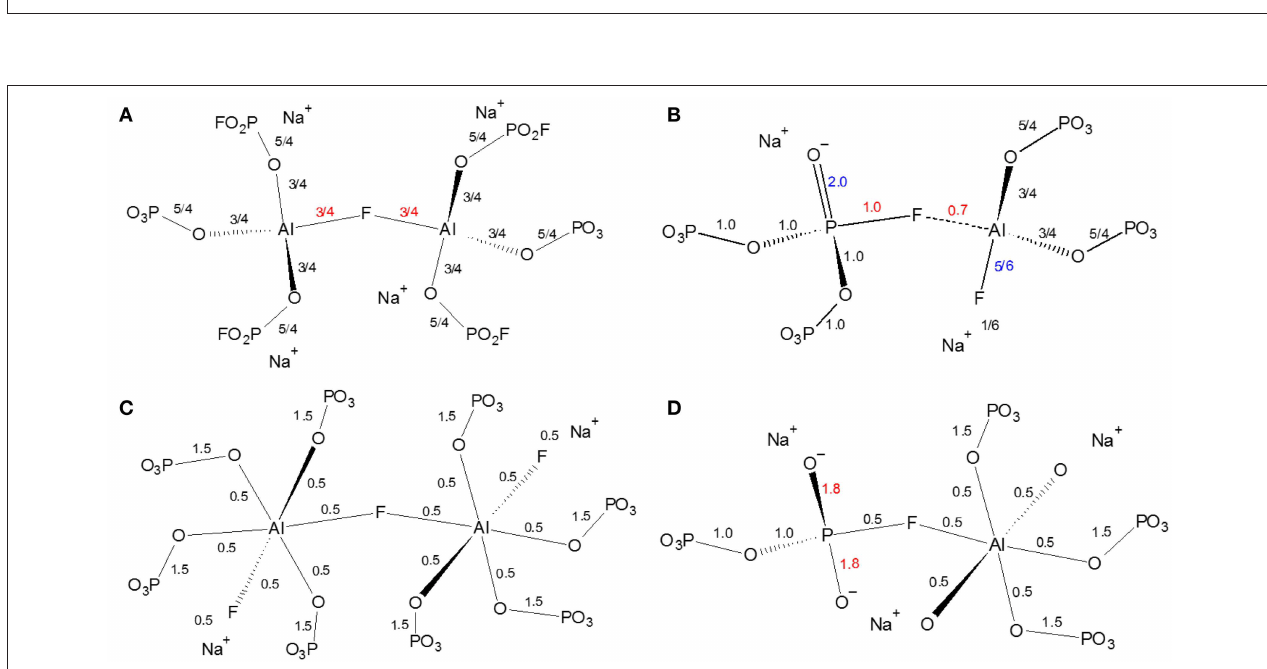
FIGURE 7 | Effect of fluoride in fluoroaluminophosphate glass in phosphate-rich (low Al/P ratio, 0.3) environment (A) instability of Al[4]—F—Al[4] bond; (B) Instability of P—F—Al[4] bond; (C) Al[6]—F—Al[6] bond; (D) Instability of P—F—Al[6] bond.